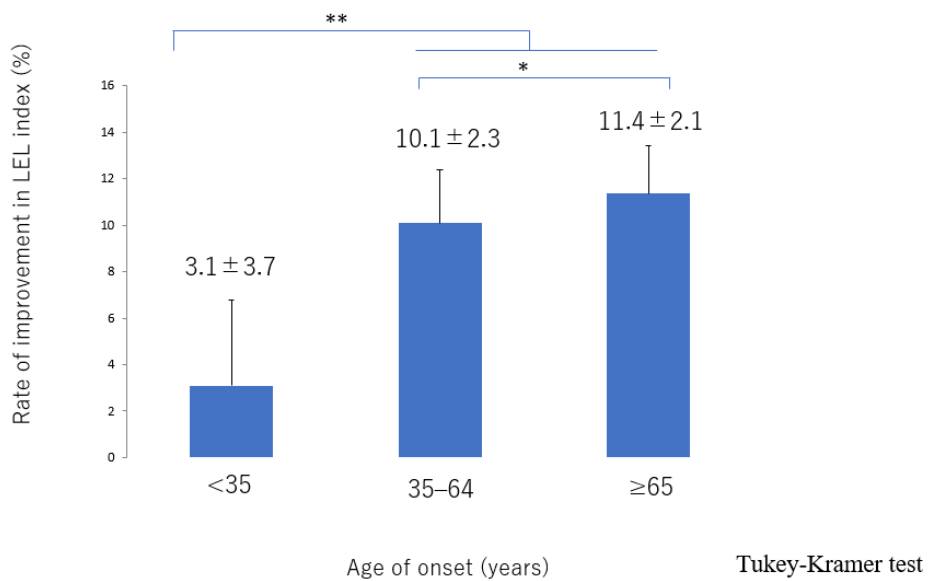
Figure 8. Rate of improvement in the LEL index score according to age of onset. The improvement was significantly greater in the 35–64 and ≥65 groups than in the <35 group and was greater in the ≥65 group than in the 35–64 group. LEL, lower extremity lymphedema * p < 0.05, ** p < 0.01 (Tukey–Kramer test).